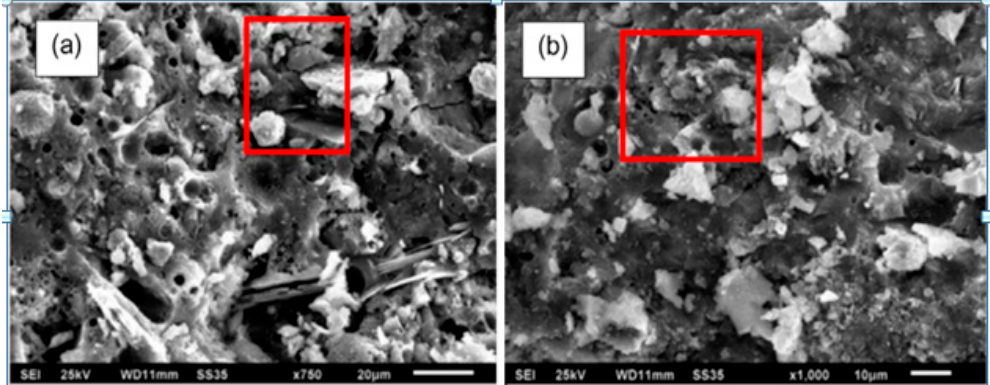
Figure 32. SEM images of GPC [9]. ( a ) Without OPC; ( b ) with OPC.